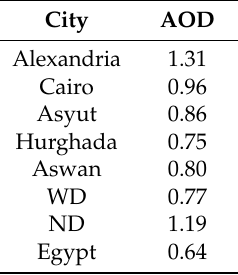
Table 2. Thresholds of AOD used to define the Severe Air Pollution Episode (SAPE) from 50 × 50 km 2 centered at each city. Data are based on averages from the entire study